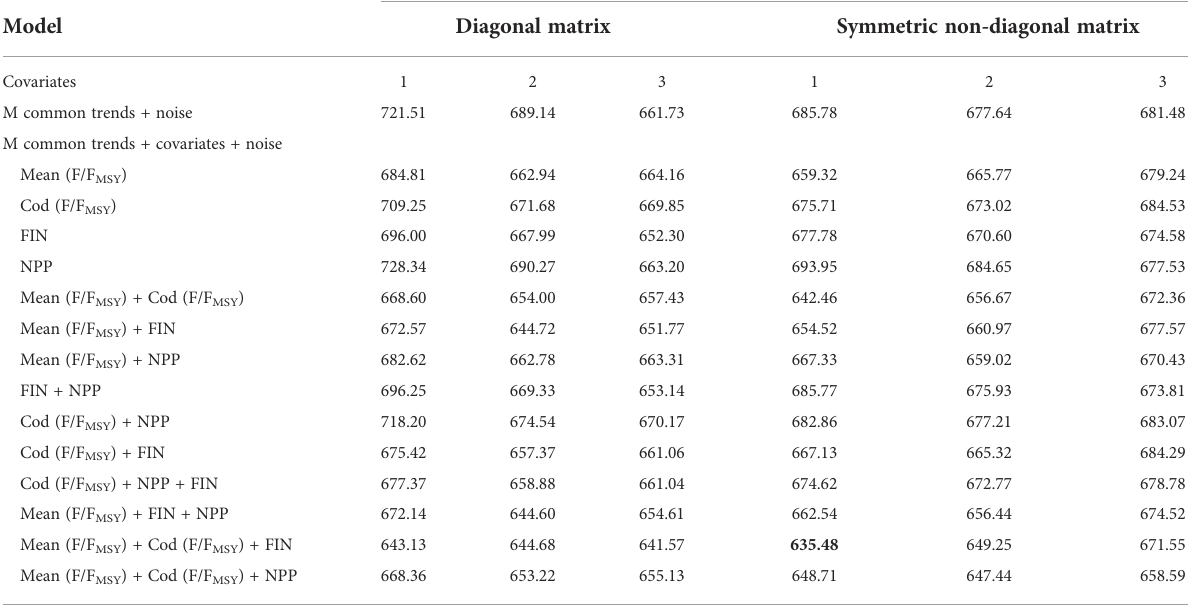
TABLE 2 Model structure and AIC values for DFA models with 1-3 common trends and 0-3